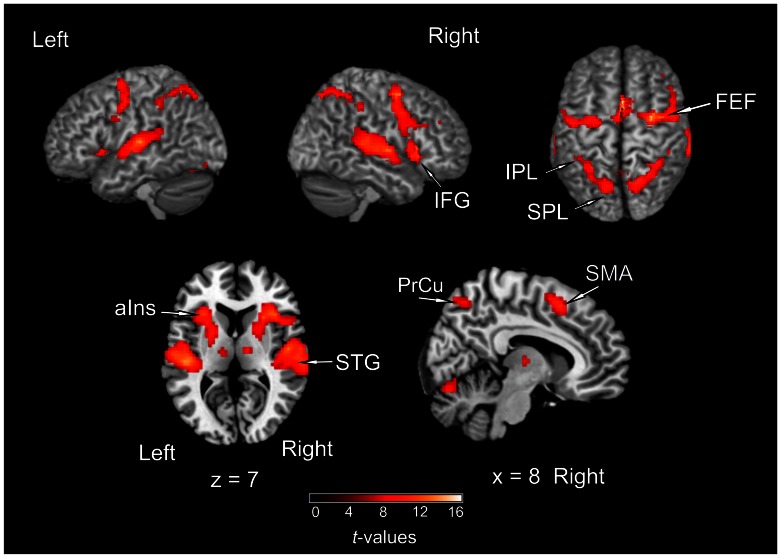
Activations of brain regions as revealed by the contrast of “cocktail” condition versus rest (p
FWE <0.05).STG, superior temporal gyrus; FEF, frontal eye fields; IPL, inferior parietal lobule; SPL, superior parietal lobule; IFG, inferior frontal gyrus; PrCu, precuneus), aIns, anterior insula; SMA, supplementary motor area. The color code refers to t-values.